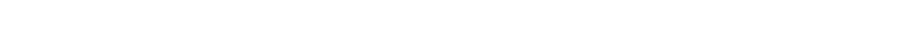
Frontiers in Neurology |